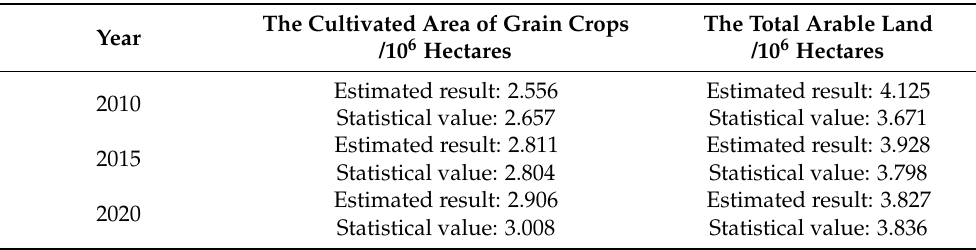
Table 7. Estimated and statistical results of cultivated area of grain crops and the total arable land in Egypt in 2010, 2015, and 2020.